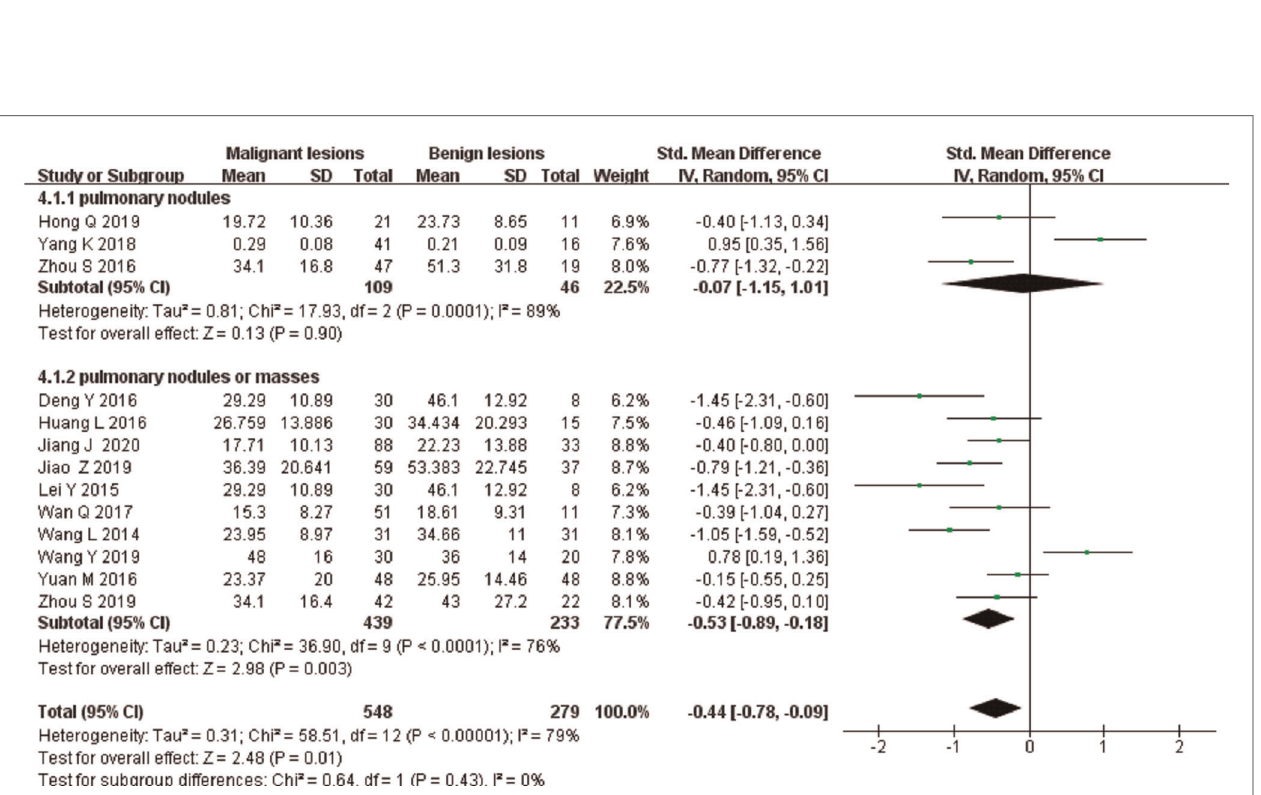
FIGURE 7 | Forest plot of the mean value of the perfusion fraction ( f value) between malignant and benign pulmonary nodules and